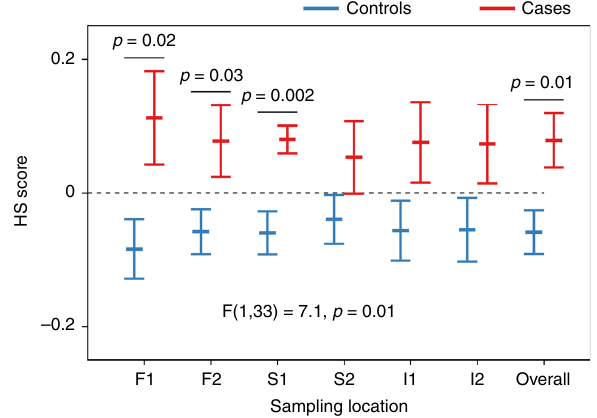
Fig. 4 Discrimination between case and control groups using hyperspectral (HS) scores. HS scores obtained at the different sampling locations were higher for cases than for controls (F 1,33 = 7.1, p = 0.01, two-way repeated measures ANOVA). Pairwise multiple comparisons (two-sided unpaired t tests controlled for false discovery rate for each comparison) show signi fi cant differences between case ( n = 15) and control ( n = 20) groups at sampling locations F1, F2, S1 and for the average of all retinal locations (overall). Data shown as mean ± SEM. Source data are available as a